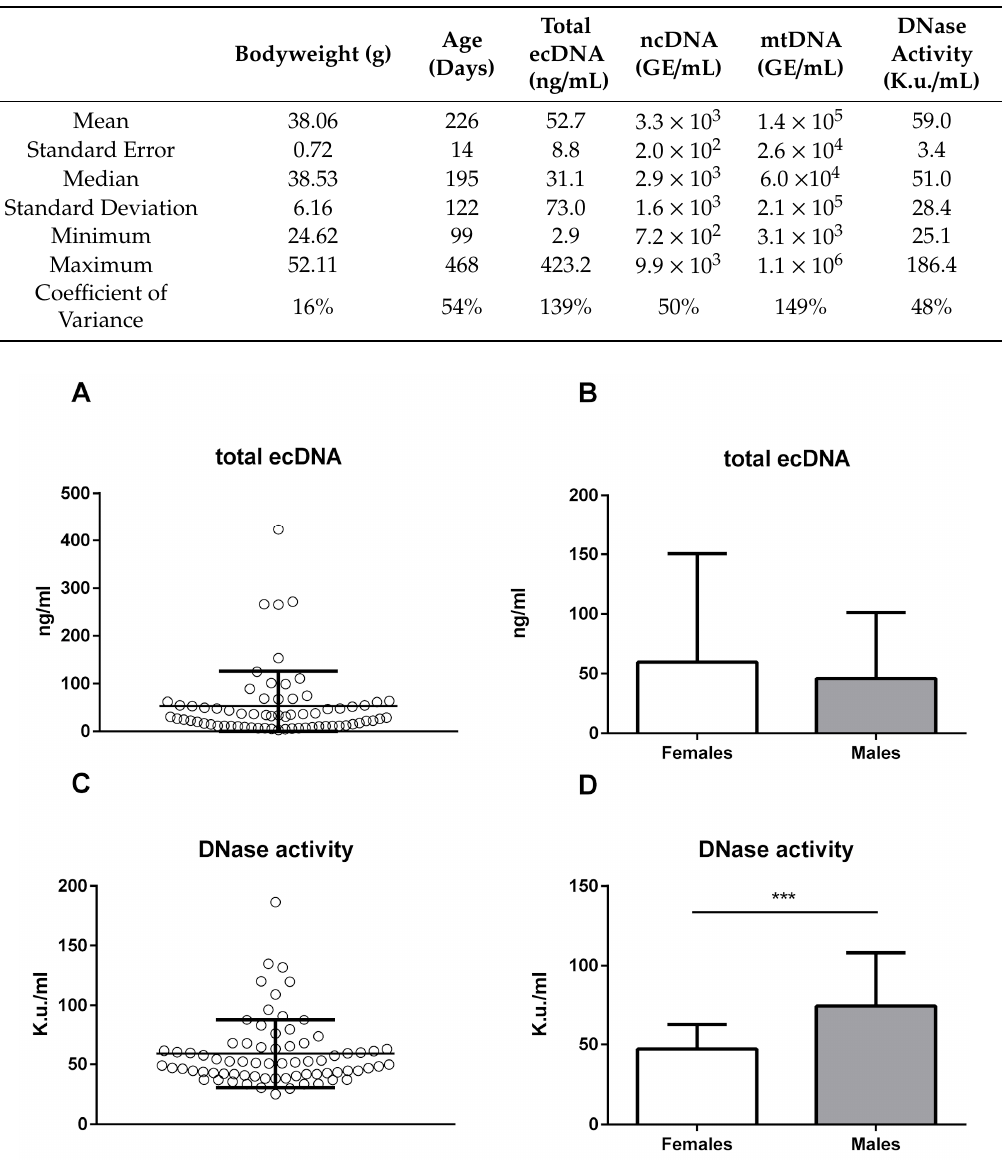
Table 1. Descriptive statistics of the measured variables, namely: bodyweight, age, plasma extracellular DNA (ecDNA), and deoxyribonuclease (DNase) activity in all of the mice combined. Age Bodyweight (g)